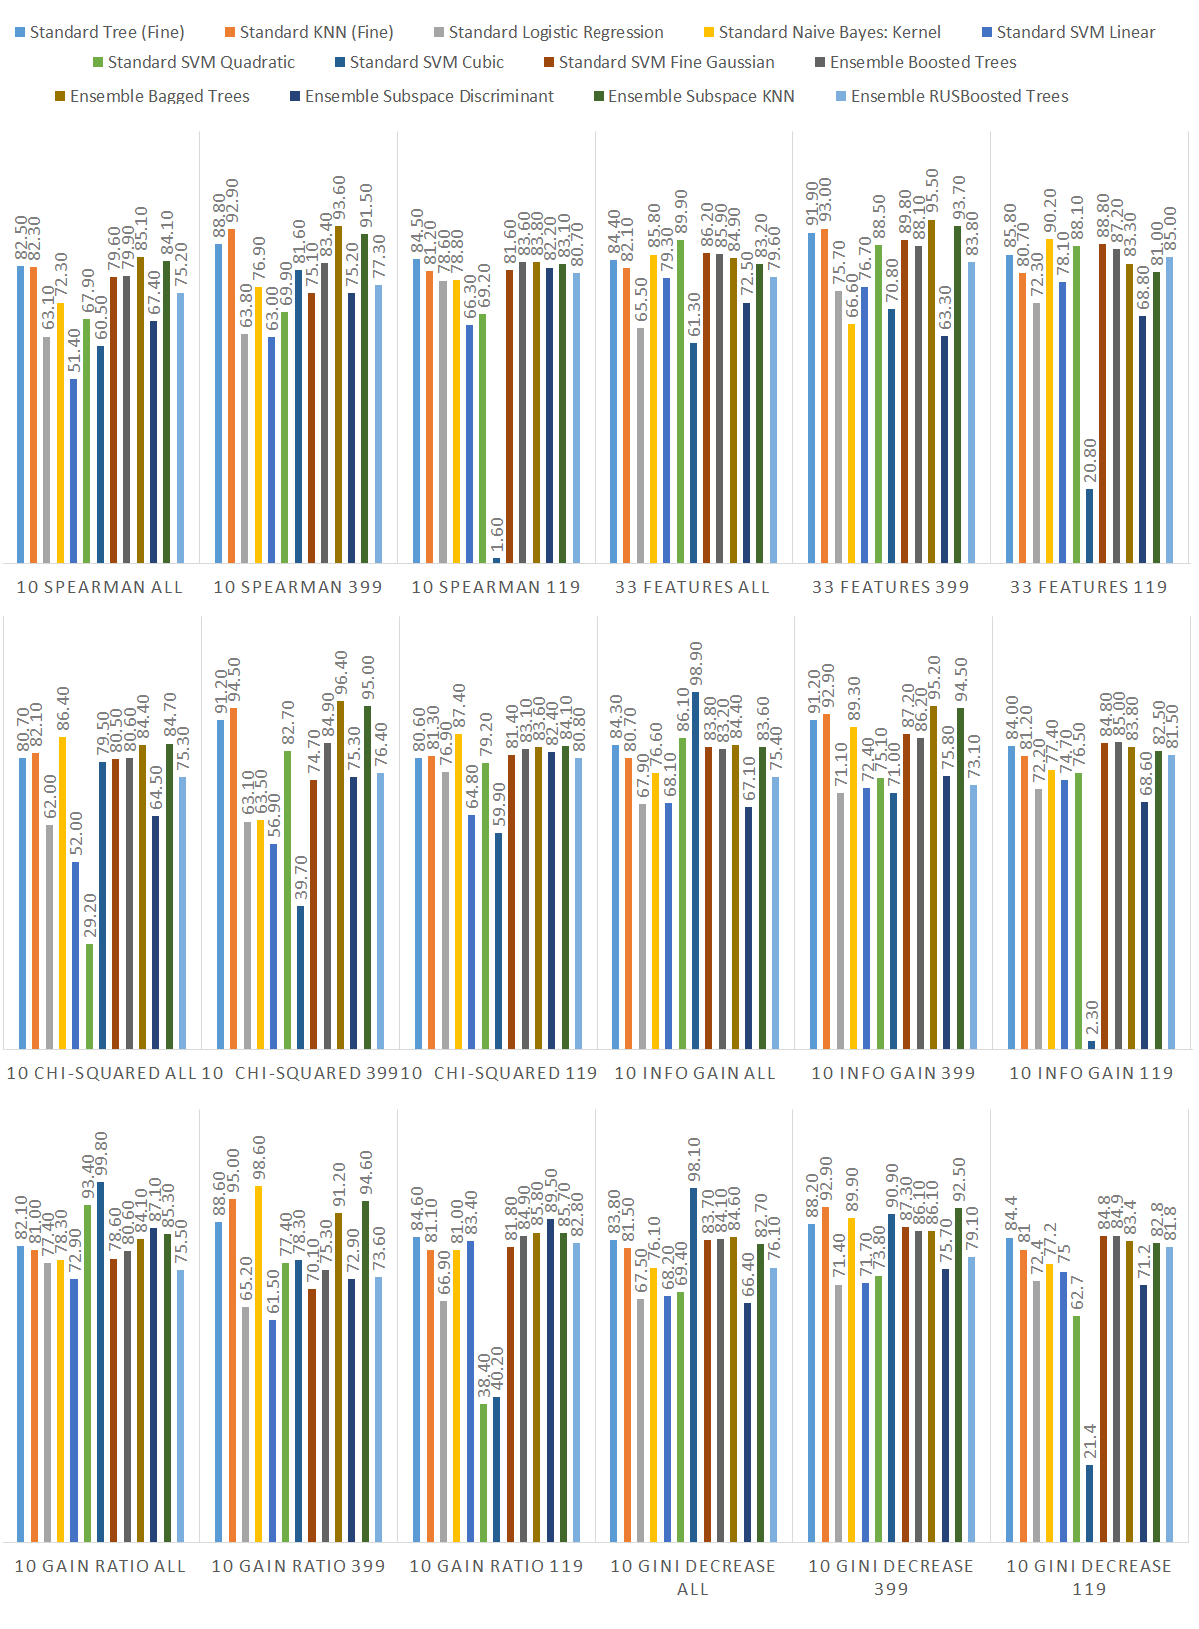
Figure 15. Detailed specificity (TNR) results for different types of